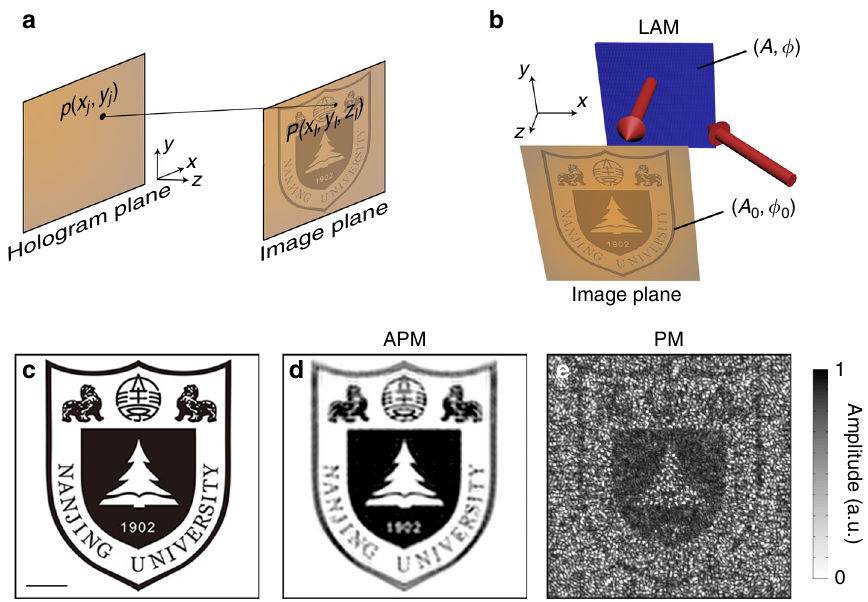
Fig. 2 High- fi delity acoustic hologram. a Schematic diagram of hologram reconstruction. b Schematic diagram of how the lossy acoustic metamaterial (LAM) projects high-quality acoustic hologram in simulation and experiment. c The target image of Nanjing University logo with complex amplitude distributions. Scale bar, 20 cm. d The simulated holographic image by the amplitude-phase-modulation (APM) method. e The simulated holographic image by the phase-modulation (PM) method. Permissions for use of the Nanjing University logo in this fi gure were obtained from Nanjing University. All rights